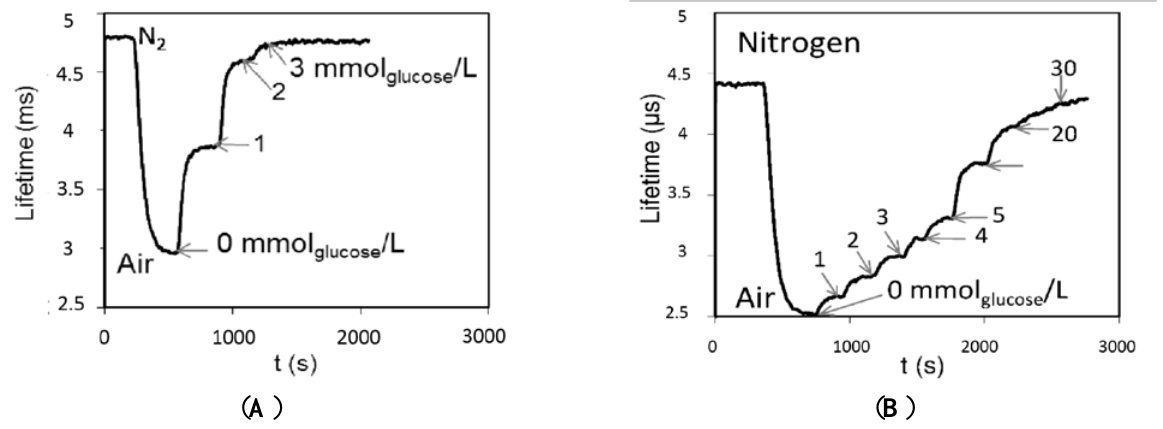
Figure 12. Optical fiber sensor of glucose for bioreactors. Record of lifetime measurement ( A ) sensitivity of the probe 20 μmol/L and linear dynamic range 2 mmol/L; ( B ) sensitivity of the probe 200 μmol/L and dynamic range 30 mmol/L.